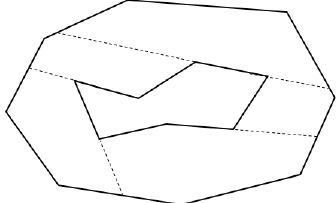
Figure 9. Final solution of the proposed method.